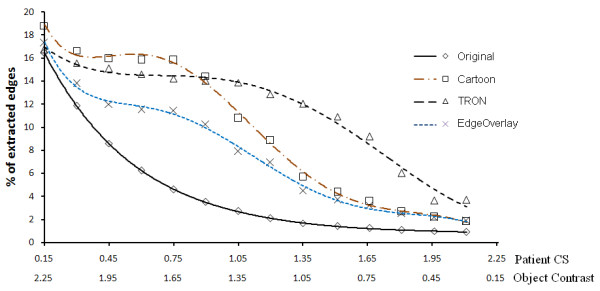
The efficacy of enhancement algorithms on the simulated pelli Robson's images at eccentricity of 5.46 mm from the macula's centre. The efficacy of each algorithm compared to the original image on an image with object at 5.46 mm from the macula's centre when changing the object contrast values.